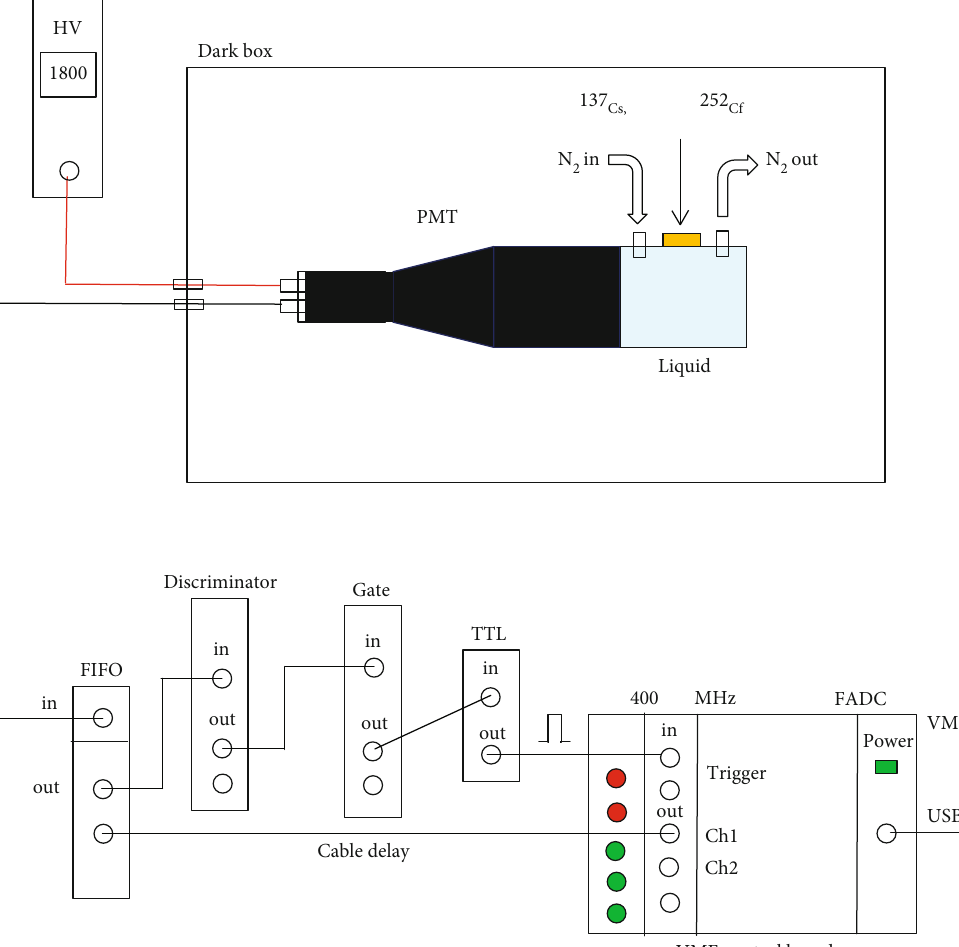
Figure 3: Schematic view of the DAQ system including a 400MHz FADC readout for light yield and PSD